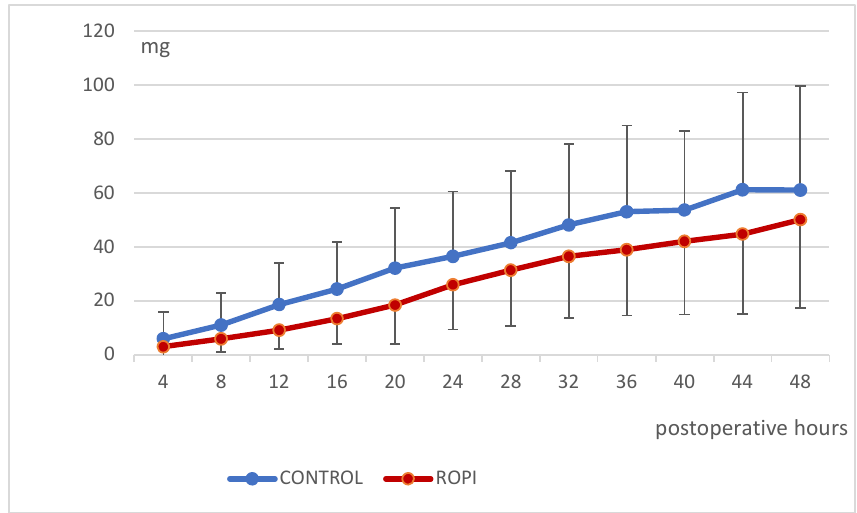
Figure 3. Pain scores at the cervical site at rest; mean and SD vs. postoperative time (hours) starting in PACU.